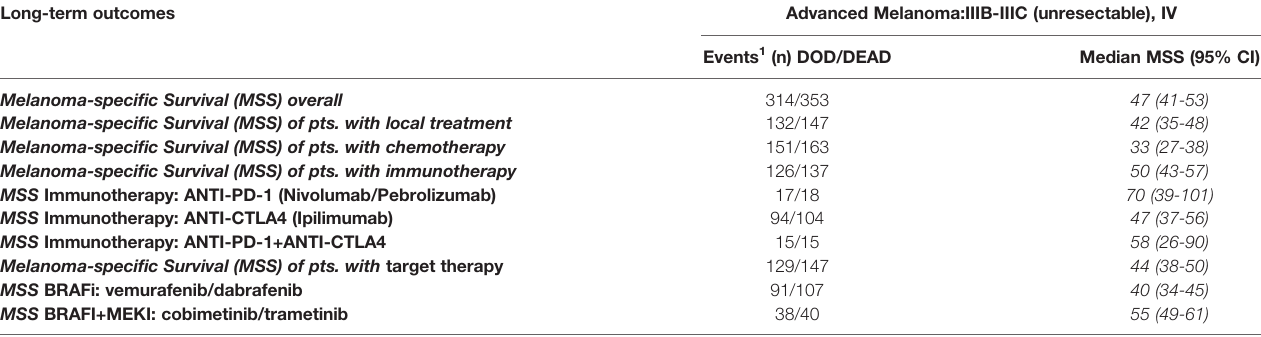
TABLE 3 | Results of the performance indicators on the quality of metastatic melanoma care – Univariate Analysis. Long-term outcomes